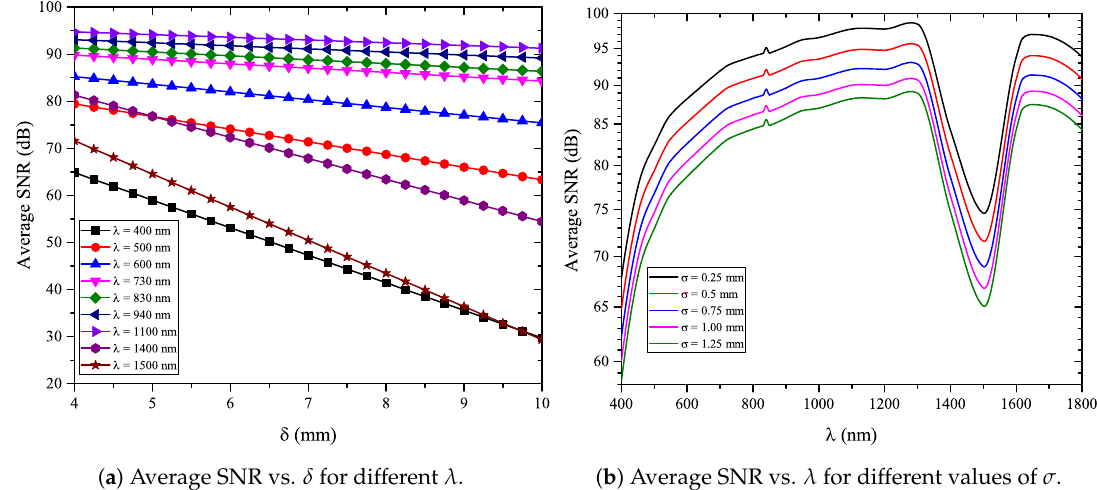
Figure 2. Impact of wavelength selectivity.